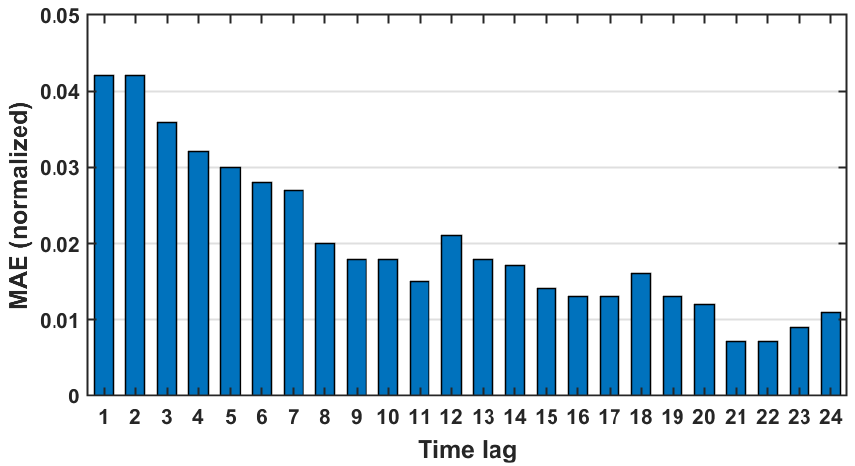
Figure 6. MAE with time-lag range (1:24) by GA. Table 4. MAE, RMSE, MAPE and R-squared values with time-lag of 21 for LSTM with GA